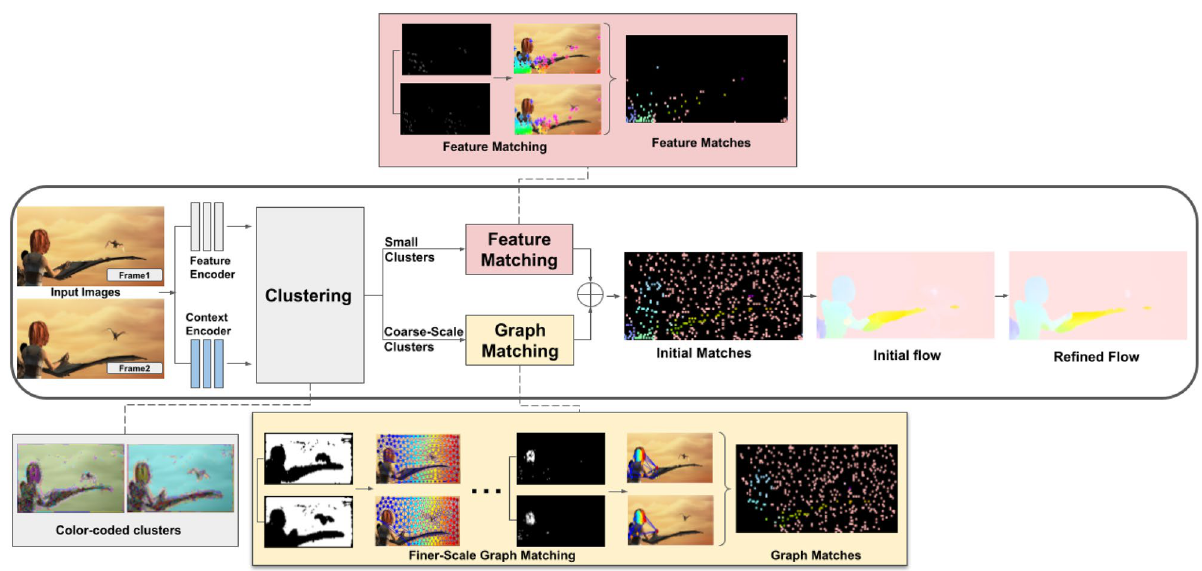
Figure 2. HybridFlow: A multi-scale hybrid matching approach is performed on the image pairs. Uniquely, HybridFlow, leverages the strong discriminative nature of feature descriptors, combined with the robustness of graph matching on arbitrary graph topologies. Coarse-scale clusters are formed based on the pixels’ feature descriptors and are further subdivided into finer-scale SLIC superpixels. Graph matching is performed on the superpixels contained within the matched coarse-scale clusters. Small clusters that cannot be further subdivided are matched using localized feature matching. Together, these initial matches form the flow, which is propagated by an edge-preserving interpolation and variational